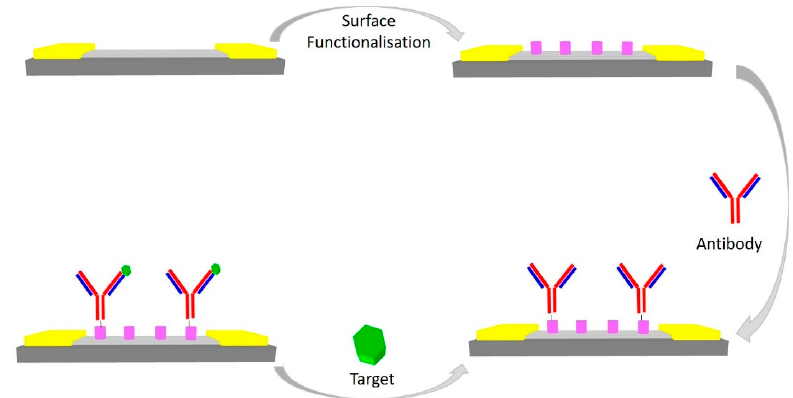
Figure 8. A schematic representation of the process flow for developing an immuno-based G-FET. Gold—Contact pads, dark grey—SiO 2 , light grey—graphene, purple—surface functionalisation.